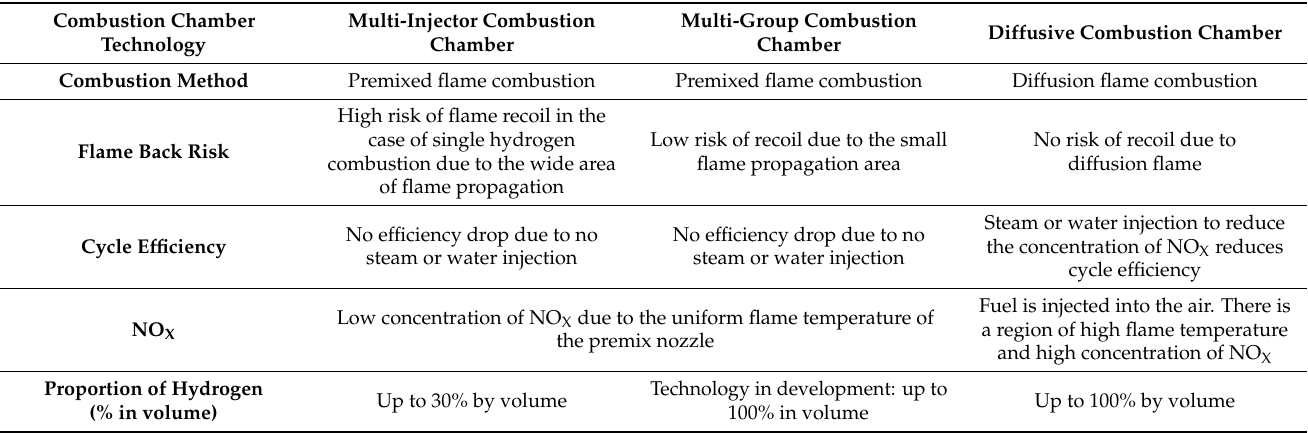
Table 6. Gas Turbines for hydrogen combustion, adapted from [43].